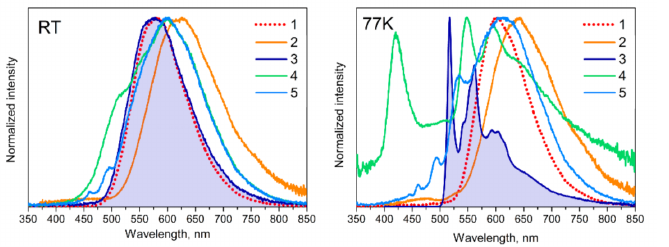
Figure 4. Normalized emission spectra of 1 − 5 in solid state at room temperature and 77 K, λ exct = 351